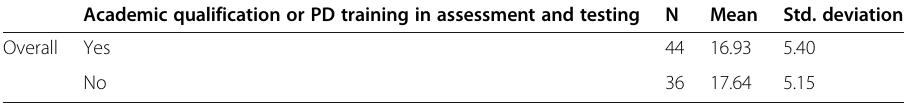
Table 4 Total questionnaire mean according to background in assessment & testing Academic qualification or PD training in assessment and